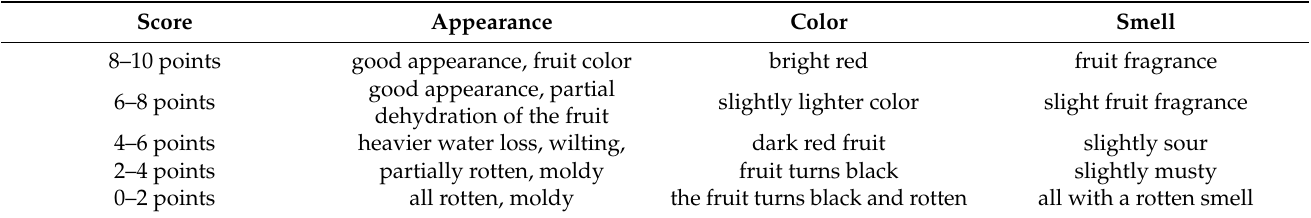
Table 3. Sensory evaluation of strawberries.